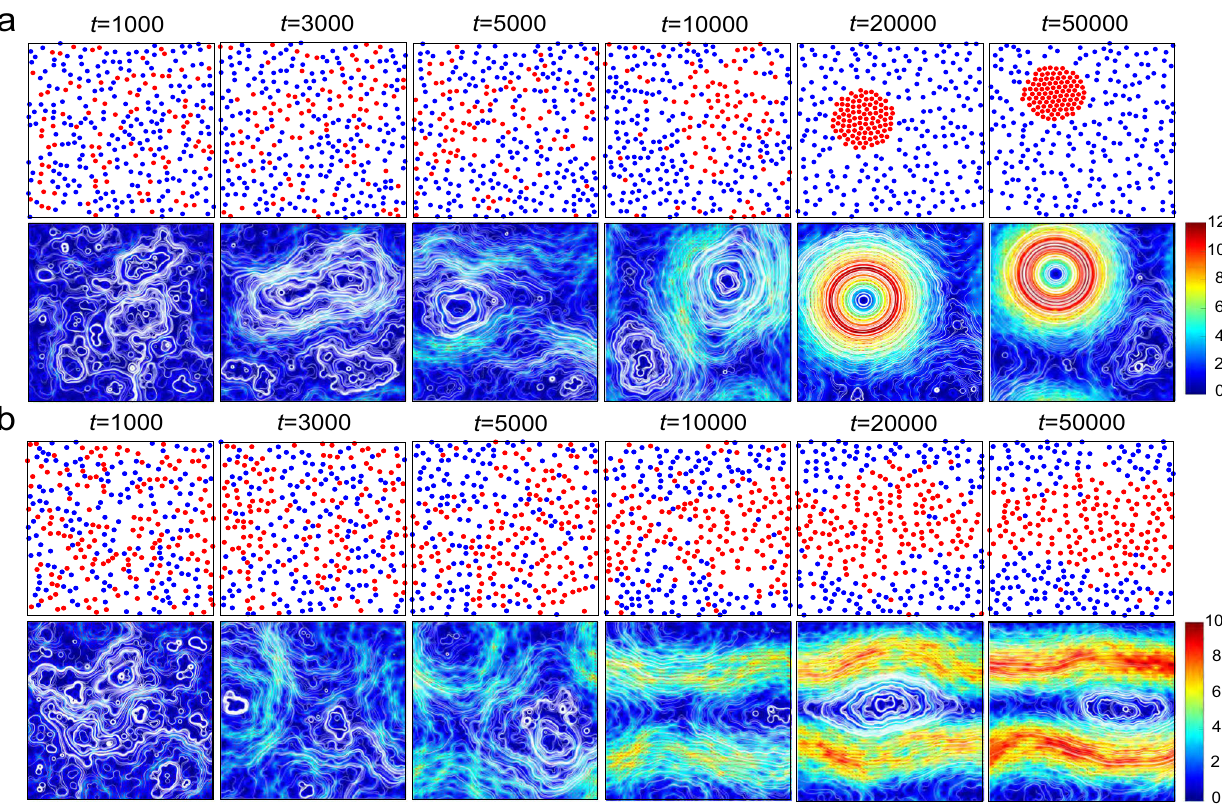
Fig. 2 Temporal change of the particle distribution, velocity- fi eld magnitude, and streamline. a Disk distribution (top row) and local velocity magnitude and streamlines (bottom row) for an off-symmetric composition (OSM) ( Φ = 0.3, Re = 10.8). Red and blue particles are counter-clockwise (CCW) and clockwise(CW) rotating disks. b The same as a for a symmetric composition (SM) ( Φ = 0.5, Re = 10.8). The colour bars show the velocity Fig. 4 for the border and Supplementary Note 4 and Supplementary Fig. 5 for the hysteresis). We can robustly reach the fi nal steady state within the reasonable computational time for Re ≥ 2 : 4, but cannot for Re ≤ 1 : 4 due to extremely slow dynamics.